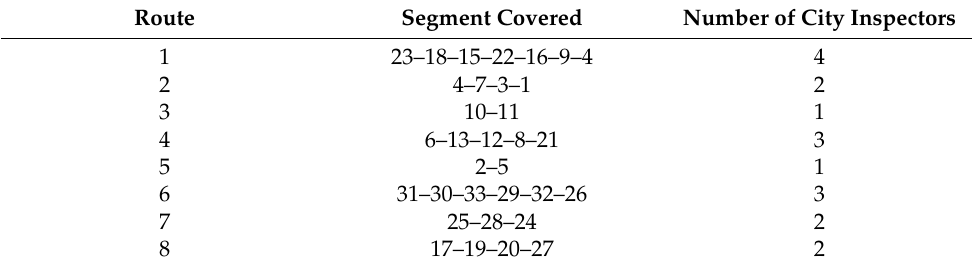
Table 5. Path patrol scheme in real scenario.